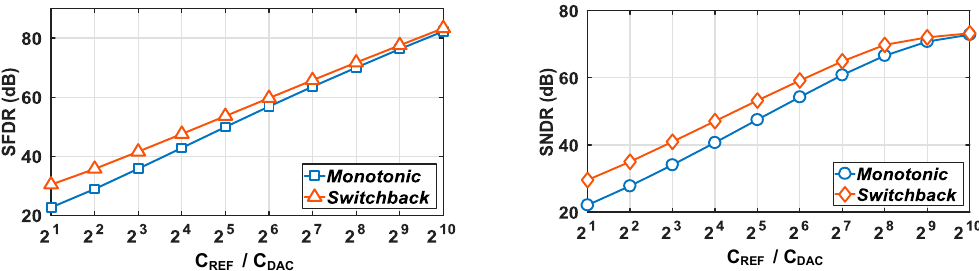
Figure 2. The dynamic performance of a behavioral simulation for a 12-bit SAR ADC with monotonic and switchback switching schemes according to C REF .